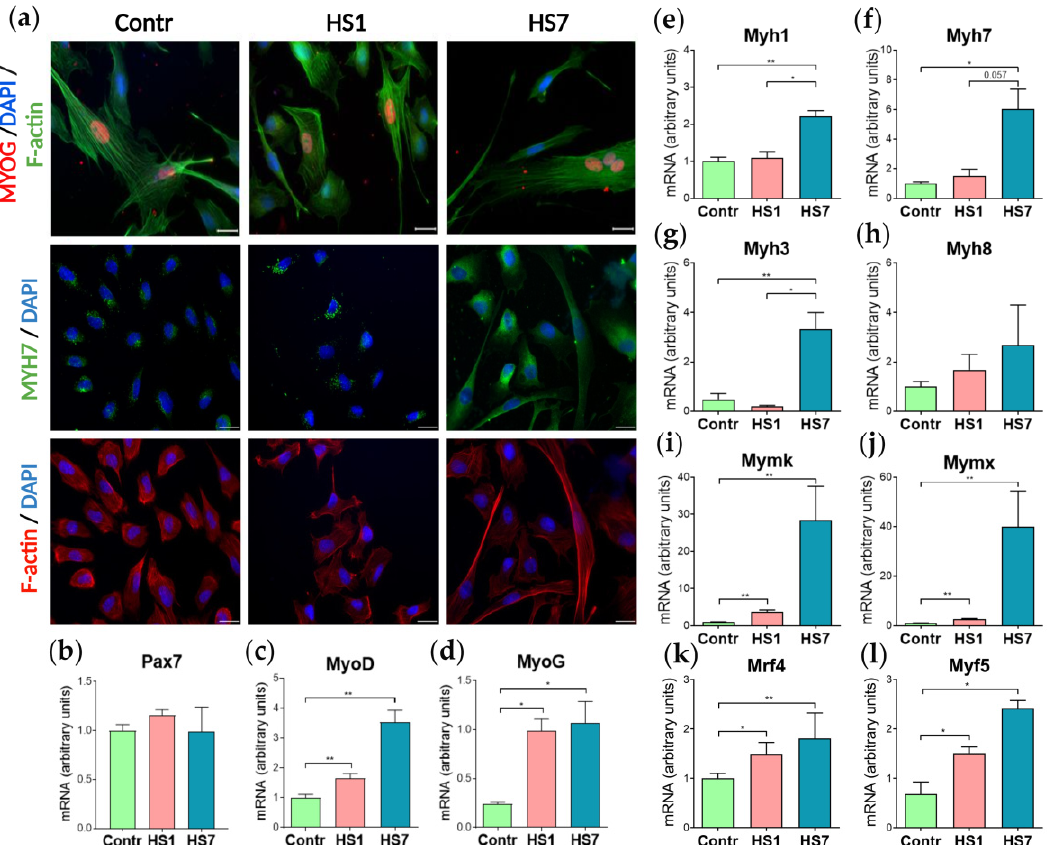
Figure 3. The effect of skeletal muscle functional unloading on myogenic factors expression in myoblasts cultured for 24 h after purification: ( a ) Immunostaining for slow myosin MYH7 in cultured myoblasts: MYH7—green, F-actin red; MYOG in non-differentiated myoblasts: MYOG red; F-actin green; nuclei blue; scale bar = 20 µm; F-actin staining was used as a positive control; ( b – l ) mRNA expression analysis: Pax7 (a marker of satellite cells); MyoD and MyoG (myogenic regula- tory factors); Myh7 (slow-twitch myosin); Myh3 (embryonic myosin); Myh1 (fast-twitch myosin); Myh8 ( fetal skeletal muscle myosin); Mymk and Mymx (myoblasts fusion markers); Mrf4 (myogenic regulatory factor); Myf5 (myogenic regulatory factor); ( n = 4; * p < 0.05; ** p < 0.01).